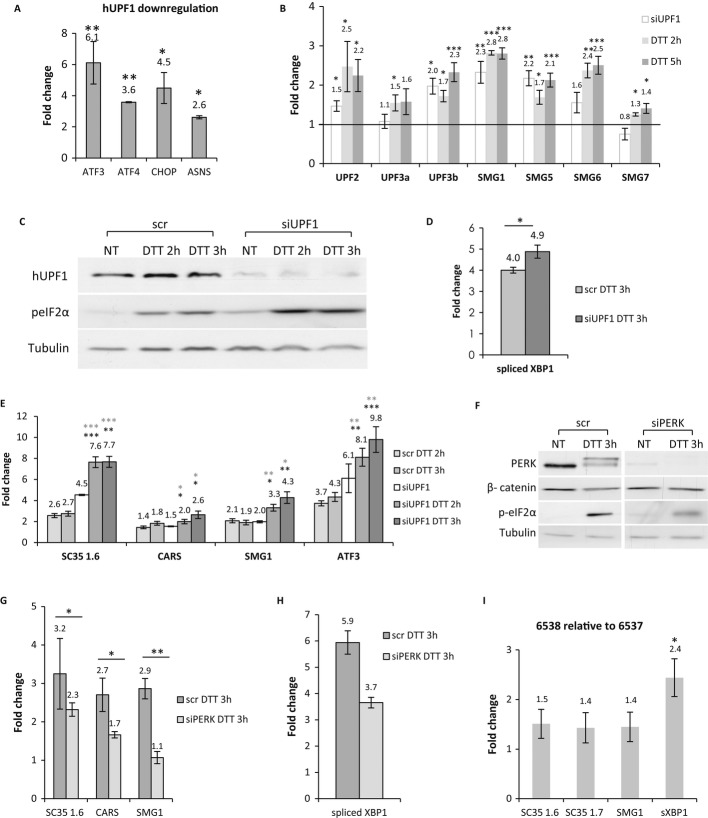
A positive feedback loop between the NMD and the UPR mechanisms.A HEK293T cells were transfected with siRNA against hUPF1 or nonspecific control siRNA (scr) for 72 h. Levels of ATF3, ATF4, CHOP, and ASNS transcripts were measured by RT-qPCR. The values shown are the average fold change (mean ± s.e.m.) from at least three independent experiments relative to nontreated cells. Values were normalized against transcripts of RNA polymerase II gene. Statistical analysis was performed using Student's t-test (one-tailed, paired). *P < 0.05, **P < 0.01, ***P < 0.001.B HeLa cells were treated with DTT (10 mM) for 2 and 5 h or transfected with siRNA against hUPF1 or nonspecific control siRNA (scr) for 48 h. The levels of the NMD factors transcripts were measured by RT-qPCR. Data were quantified and statistically analyzed as in (A).C–E HEK293T cells were transfected with siRNA against hUPF1 or nonspecific control siRNA (scr) for 72 h with or without DTT treatment (10 mM) for 2 or 3 h. (C) Protein extracts were prepared and analyzed by immunoblotting with anti-hUPF1, anti-tubulin, and anti-peIF2α antibodies. (D) Levels of spliced XBP1 and (E) SC35 1.6, CARS, SMG1, and ATF3 transcripts were measured by RT-qPCR. Data were quantified and statistically analyzed as in (A). All the changes following UPR activation by DTT and UPF1 downregulation were significantly higher compared to nontreated or scr cells. Black asterisks: scr DTT/siUPF1 DTT. Gray asterisks: siUPF1 DTT/siUPF1.F–H HEK293T cells were transfected with siRNAs against PERK or nonspecific control siRNA (scr) for 72 h with or without DTT treatment (10 mM) for 3 h. (F) Protein extracts were prepared and analyzed by immunoblotting with anti-PERK, anti-tubulin, anti-β catenin, and anti-peIF2α antibodies. (G) Levels of SC35 1.6, CARS, and SMG1. (H) Levels of spliced XBP1 (P-value = 0.05).I SC35 1.6, SC35 1.7, SMG1 and sXBP1 transcripts were measured by RT-qPCR. Data represent the ratio between 6538 and 6537 lymphoblastoid cell lines. Data were quantified and statistically analyzed as in (A).